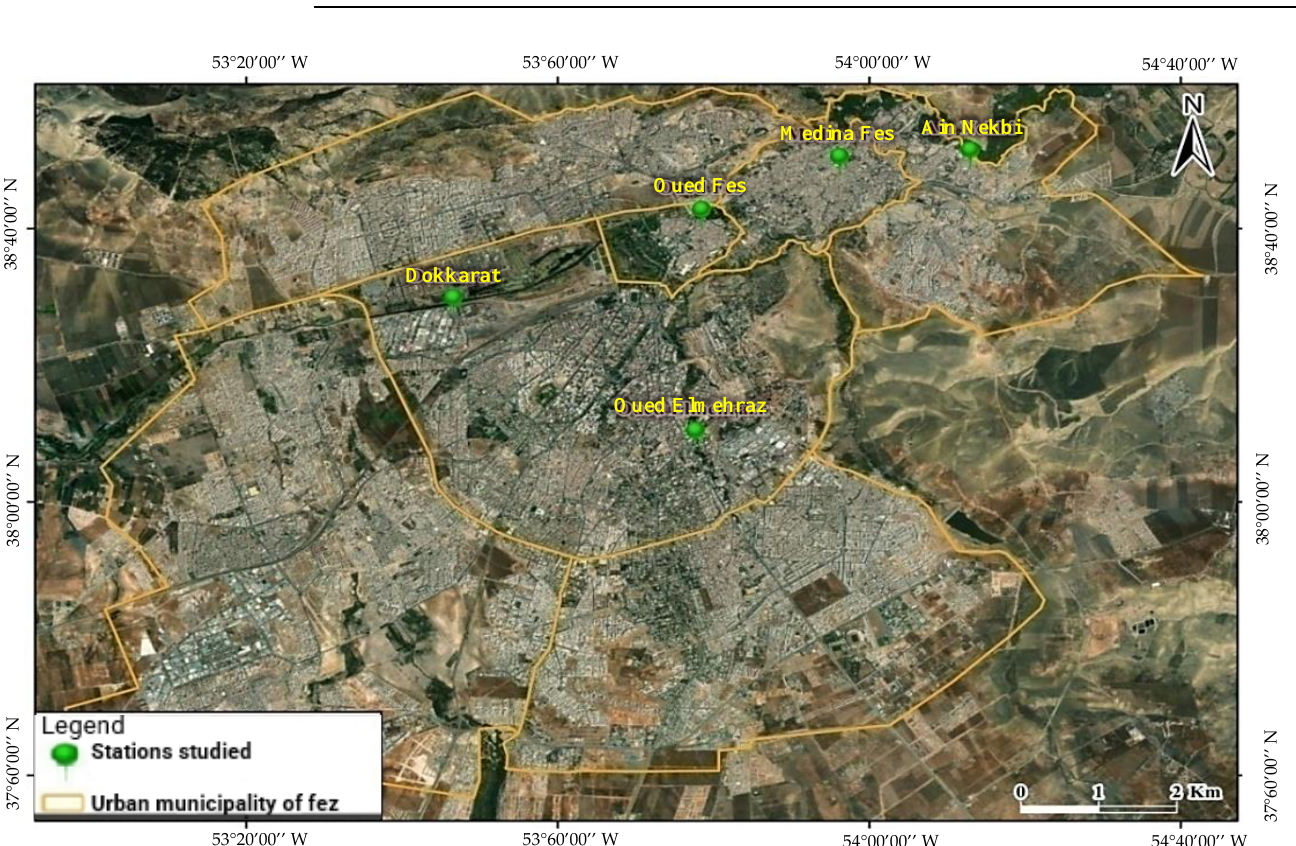
Figure 1. Map of the sampling stations. Figure 9. Map of the sampling